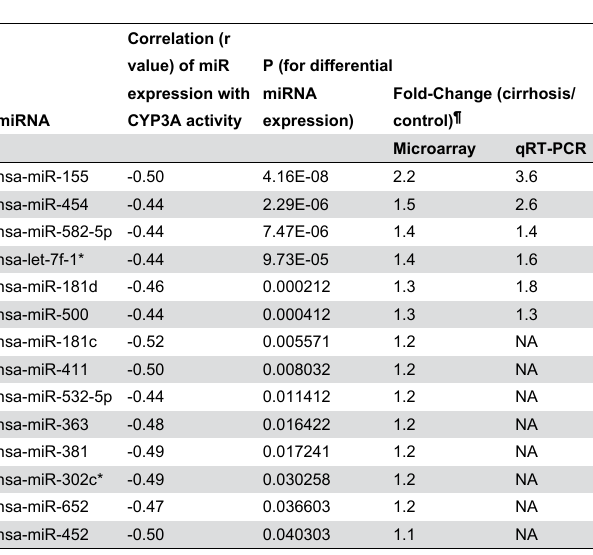
Table 2. miRNAs that are upregulated in cirrhotic livers and had significant negative correlation with hepatic CYP3A activity.